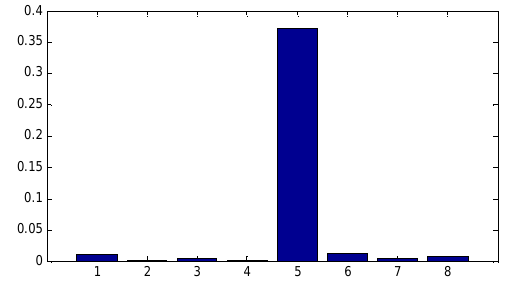
Figure 19. The distribution of the frequency band energy on the aero-engine rotor in case 2.